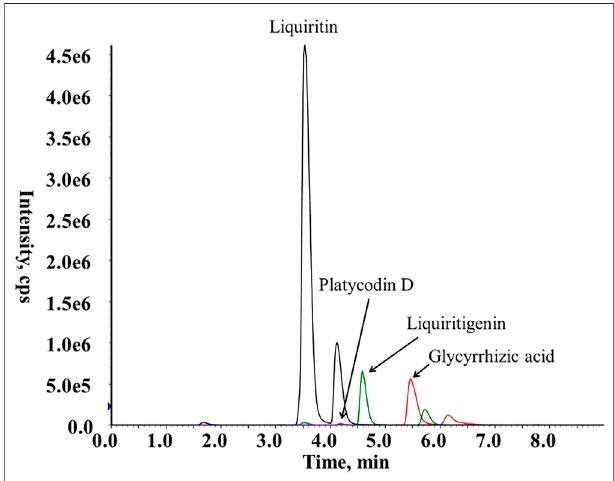
FIGURE 1 | MRM chromatograms of